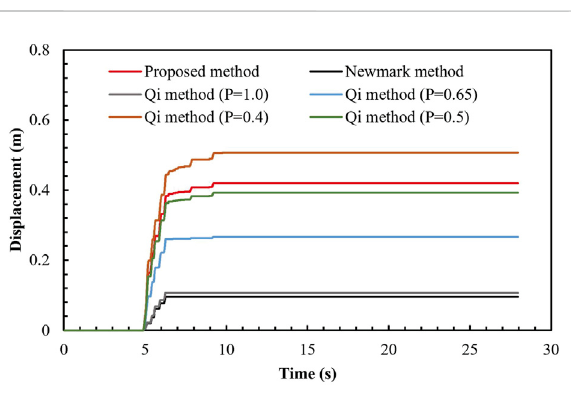
FIGURE 11 Permanent displacements obtained by different